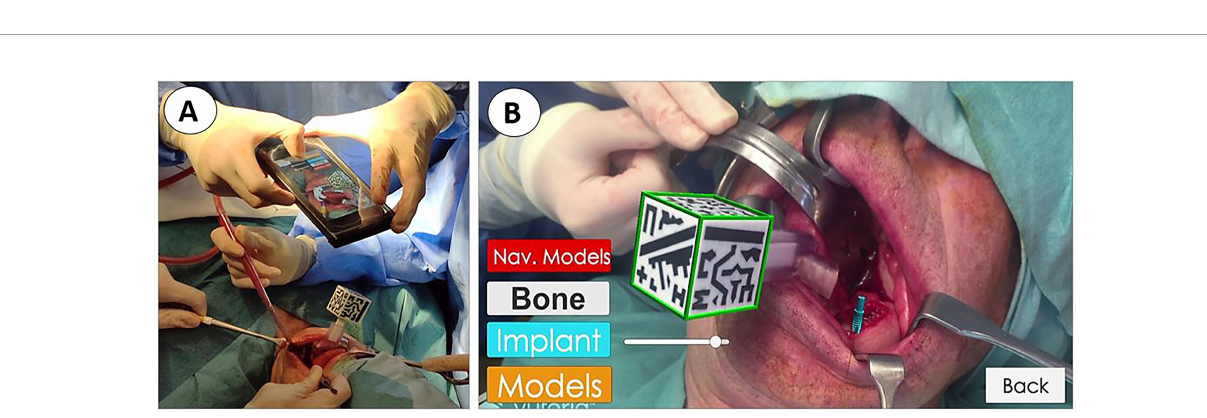
FIGURE 6 | Veri fi cation of implant position using augmented reality visualization. (A) Surgeon using a smartphone inserted into a sterile cover. (B) Augmented reality visualization of the virtual surgical plan overlaid on the patient ’ s anatomy.